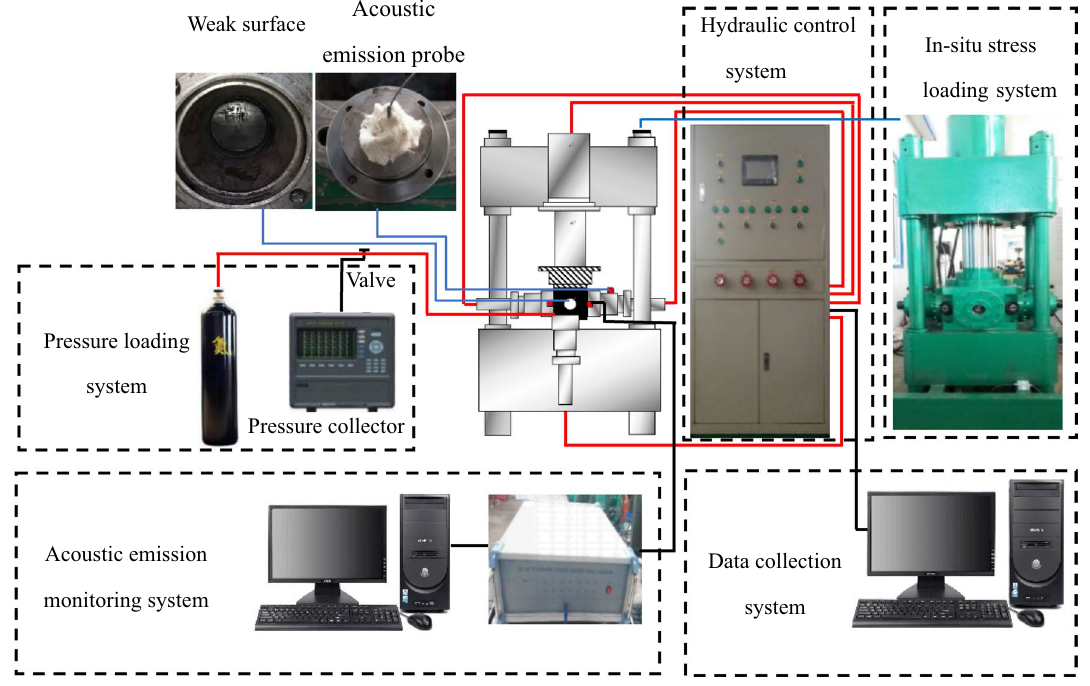
Fig. 1 Coal and gas outburst testing system (red lines: pipe connections, black lines: wires, blue lines: guide